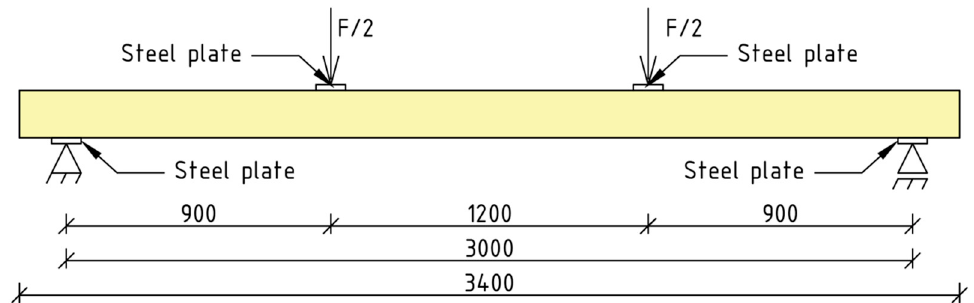
Figure 8. Scheme of static test setup.